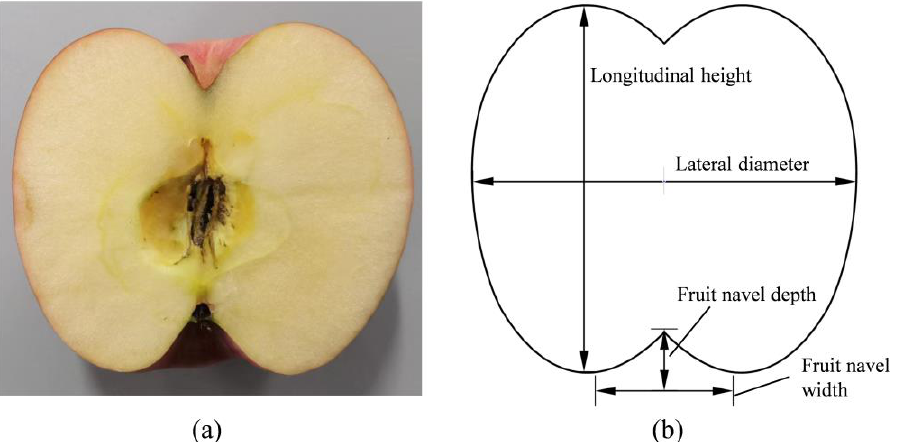
Figure 4. ( a ) Real apples; ( b ) Fruit shape parameters.